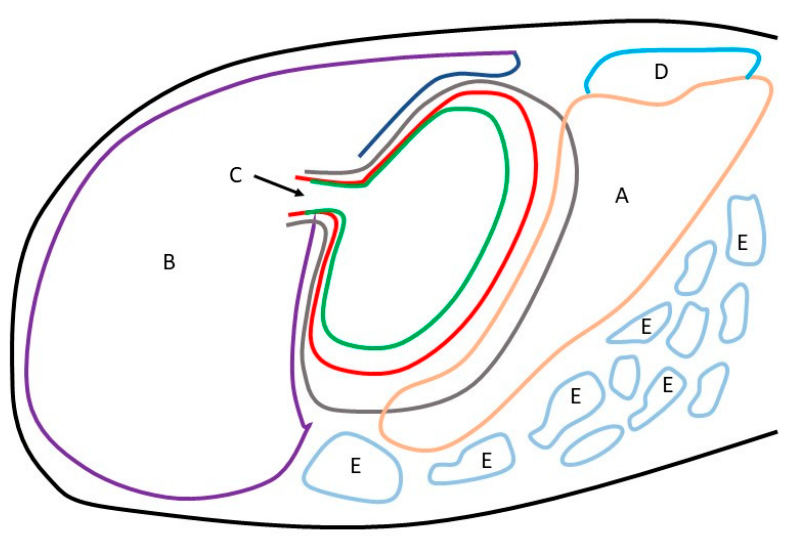
Figure 4. Topography of the stomach in the fetal period (lateral view). Green—first age group; red—second age group; black—third age group; A—spleen; B—liver; C—cardiac orifice; D—kidney; E—small and large intestine.